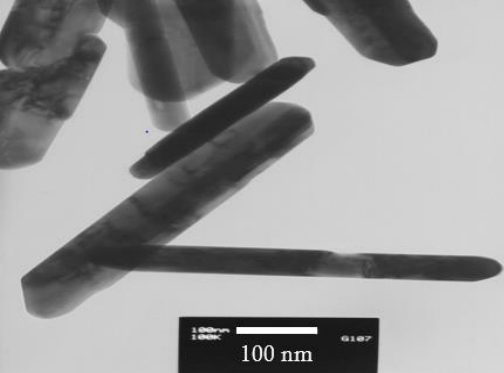
Fig. 5. TEM image of the pure CdWO